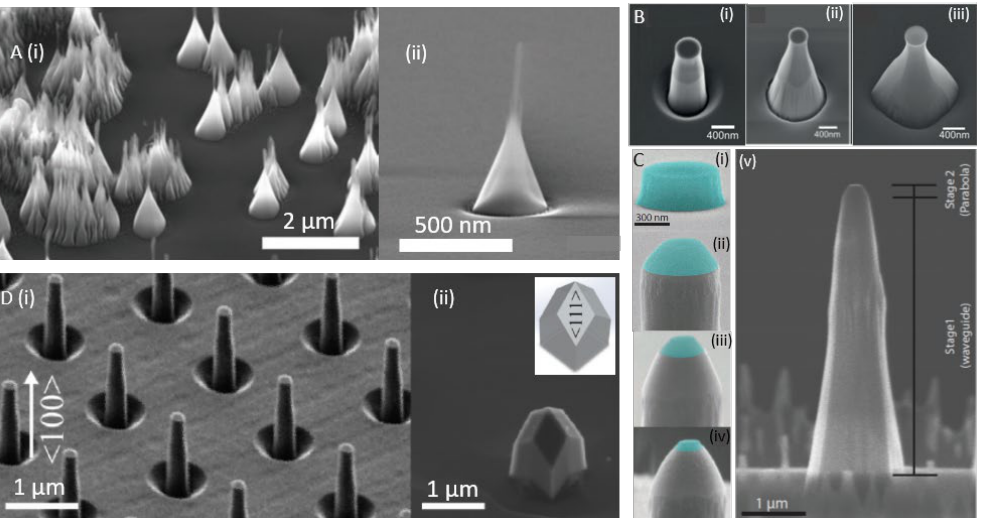
Figure 3. Scanning electron microscopy images of ( A ) (i) Tapered diamond nanopillars ((001)-oriented) with tip and conical base diameter of 15 nm and 200 nm patterned via ICP-RIE using silica bead masking layer over CVD grown diamond. (ii) High-resolution image of a single tapered nanopillar. Images reprinted with permission from Ref. [51] © 2020 WILEY- VCH Verlag GmbH & Co. KGaA, Weinheim; ( B ) Crystallographic orientation dependent etching of diamond to achieve nanopillars (top diameter of 350 nm and length of 1.5 µ m) with tapering angles (half apex angle) of (i) 3.4 ◦ , (ii) 11.5 ◦ , (iii) 21 ◦ obtained by varying the RF power during dry etching process. Images reprinted with permission from Ref. [52] © 2018 WILEY-VCH Verlag GmbH & Co. KGaA, Weinheim; ( C ) Images depicting the fabrication process of diamond nanopillars with parabolic curvature, (i) 300 nm thick, 1 µ m wide disc shaped resist (FOX-16) mask patterned via E-beam lithography, (ii) first step of dry etching (ICP-RIE) to erode the mask at the edges, have trapezoidal cross-section with base diameter of 900 µ m, (iii, iv) subsequent etching with controlled erosion of resist mask to obtain parabolic diamond surface, (v) Final nanopillar consisting of a parabolic tip with a ≈ 200 nm flat end-facet and long tapered waveguide region. Figure reprinted from Ref. [20] under creative commons CC BY 4.0 license; ( D ) (i) Cylindrical diamond nanopillars (200 nm diameter and 2 µ m length) fabricated using a combination of E-beam lithography and dry etching methods followed by (ii) an overgrowth step using microwave plasma enhanced CVD technique to obtain pyramidal pillars. Inset: schematic representation of the resulting pyramids with <111> crystal facet. SEM images taken at 45 ◦ angle. Figures reprinted from Ref. [53] within the open access publishing agreement of the Optical Society of